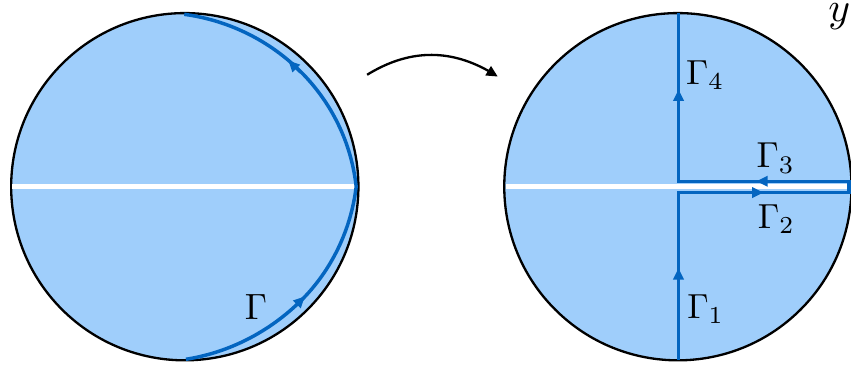
Figure 7 . The contour deformation in the y -coordinate used to (cid:12)nd a closed formula (4.43) for the coe(cid:14)cients b j of the extremal functional in the y -derivative basis. The white stripe shows the branch cut of h ( x